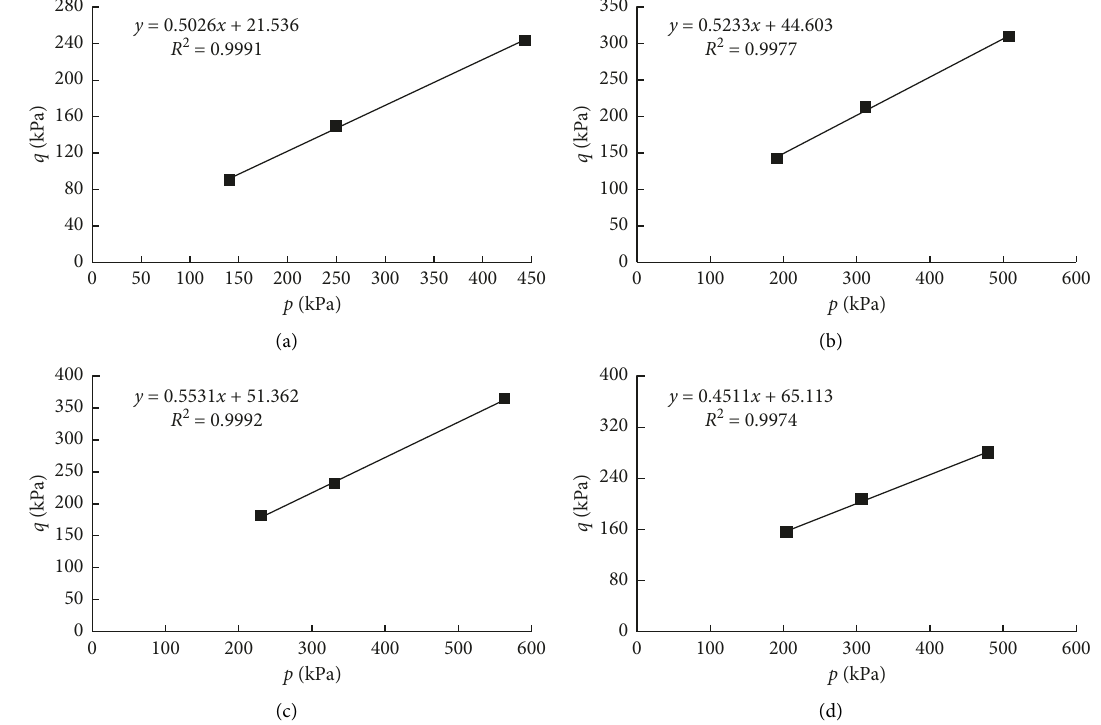
Figure 9: p-q relationship of acid-contaminated clay cured by lime. (a) 3% HCL concentration. (b) 0.5% lime content. (c) 1.0% lime content. (d) 1.5% lime content.